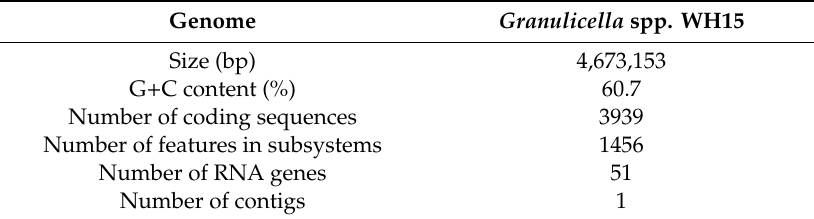
Table 1. Genomic